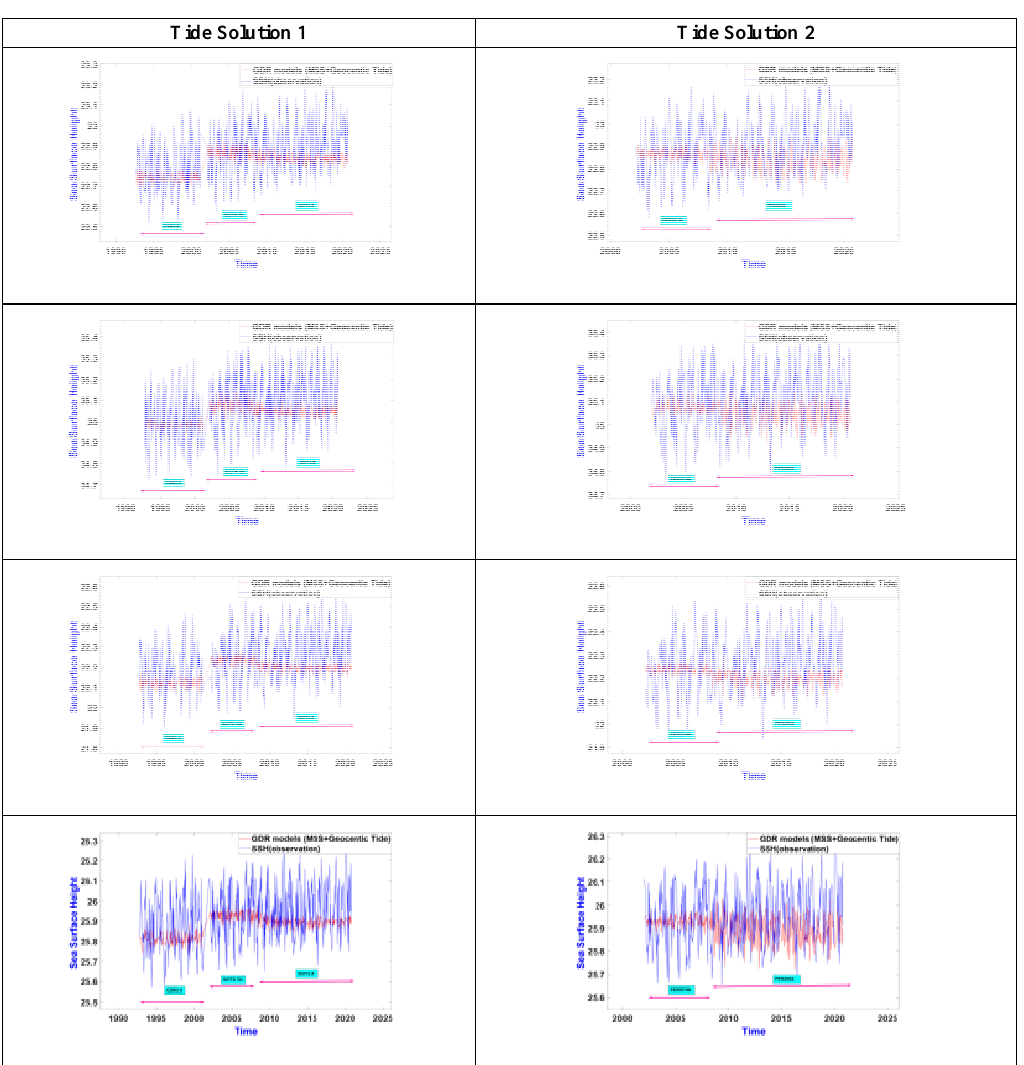
Figure 4 . SSH values generated by the sum of ocean tide and MSS values given in GDR files (red plots) and observed ones (blue plots) at four sample points over the Baltic Sea, based on tide solution 1 (red plots of column 1) and tide solution 2 (red plots of column 2).